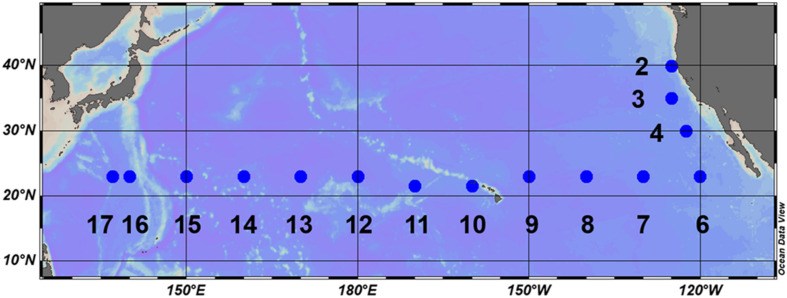
Location of stations during the KH-17-4 cruise (August–October 2017).